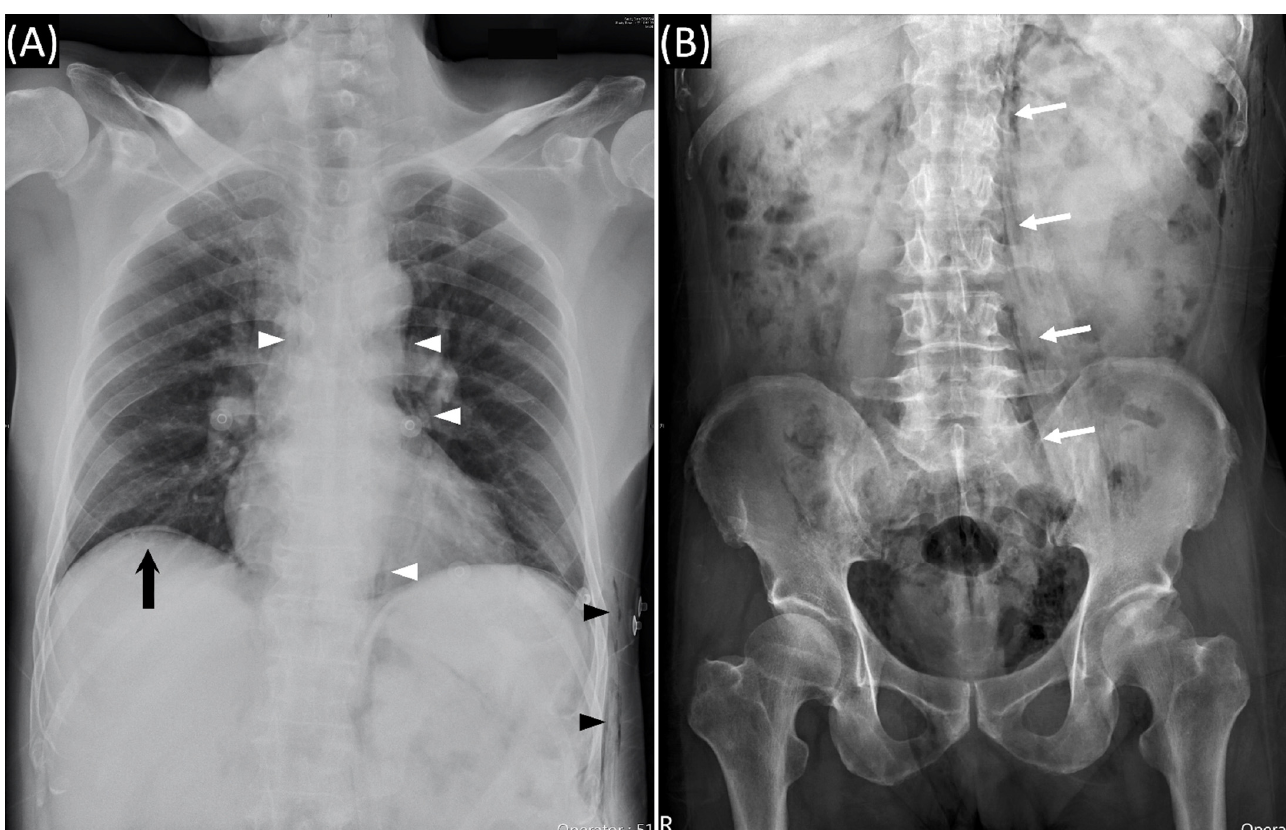
Figure 1. One wound was found at lateral perianal area of the patient.